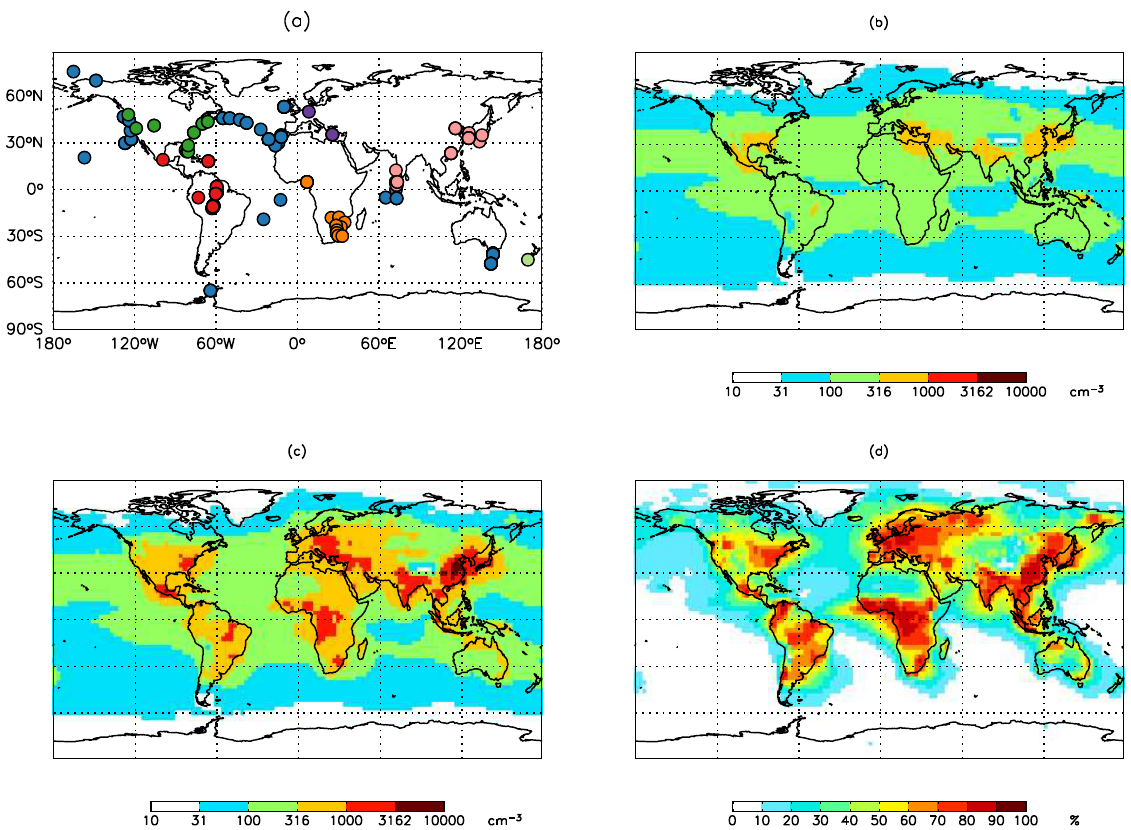
Fig. 1. (a) Locations of the cloud condensation nuclei (CCN) observations compiled in this analysis (colour scale matches Fig. 2a and b) and (b–d) simulated annual mean surface concentration of CCN. Model simulations are (b) without carbonaceous combustion aerosol acting as CCN and (c) with carbonaceous combustion aerosol acting as CCN. (d) Percentage contribution of carbonaceous combustion aerosol to CCN. CCN concentrations are calculated at 0.2%